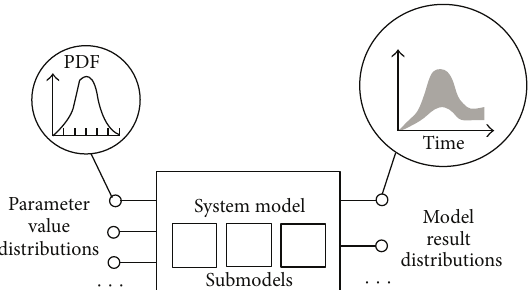
F 10: Scheme of statistical uncertainty analysis [12].